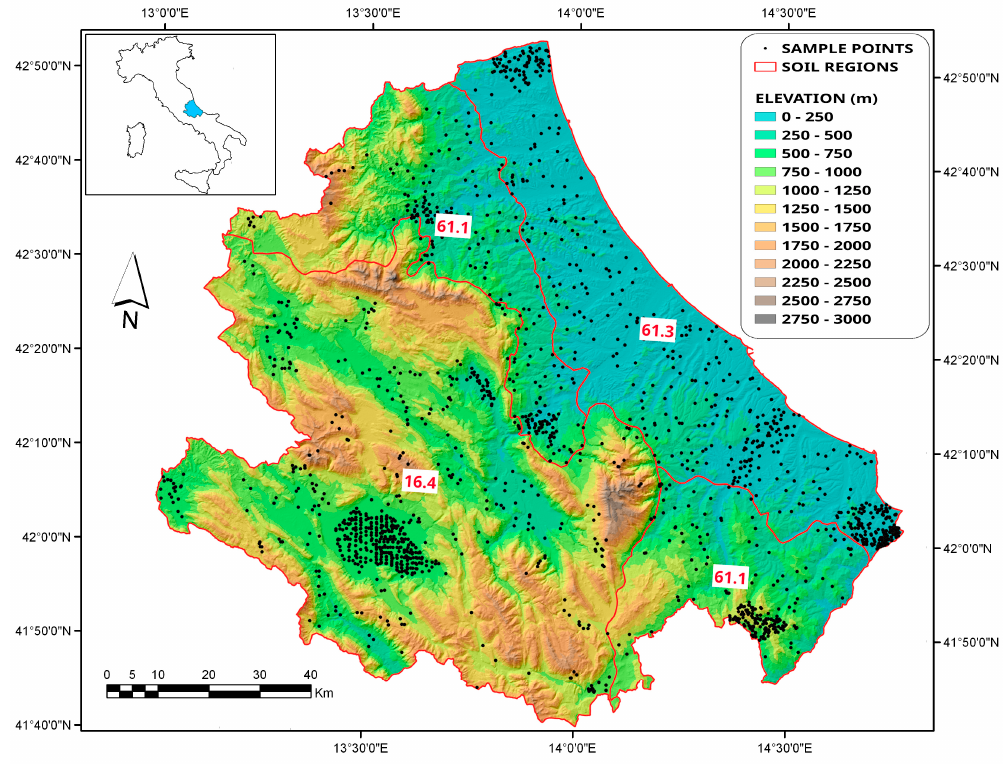
Figure 1. Digital elevation model draped on a hillshade, with the location of the sampling points and boundaries of the soil regions.